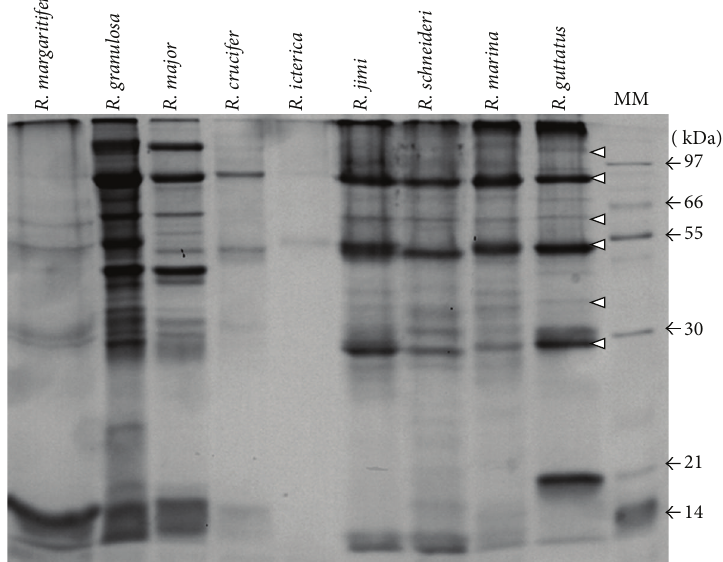
Figure 4: CBB stained SDS-PAGE of the parotoid secretion solutions analyzed in this work. MM: molecular mass marker. White arrow heads indicate the most constant proteins throughout the species.